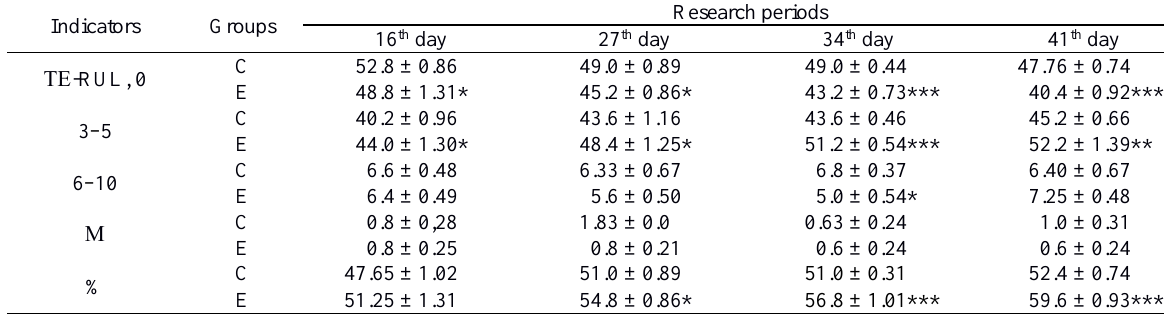
The number of TE-RUL and their functional activity in the blood of broiler chickens, % (M ± m; n = 5) Indicators